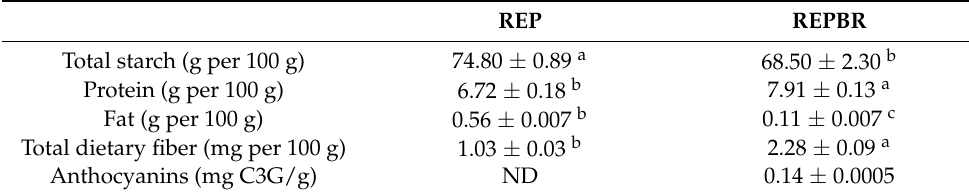
Table 1. Nutritional composition of REP and